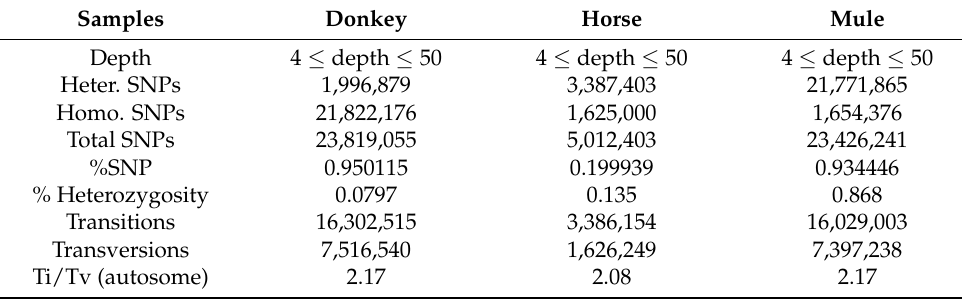
Table 1. Summary of SNPs aligning to the horse reference genome ( EquCab3.0 ). Samples Donkey Horse